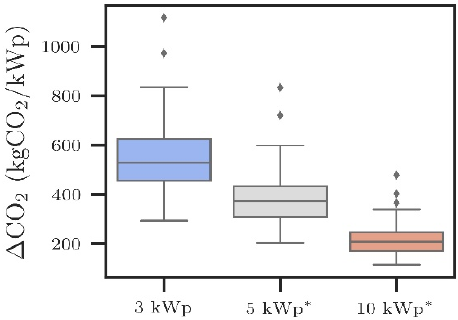
Figure 13. Reduction of CO 2 emissions per installed PV capacity on a household level. (* upscaled from 3 kWp PV generation profiles).